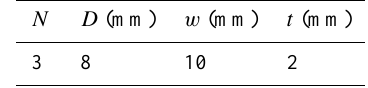
Table 1. Solenoid coil design parameter summary.